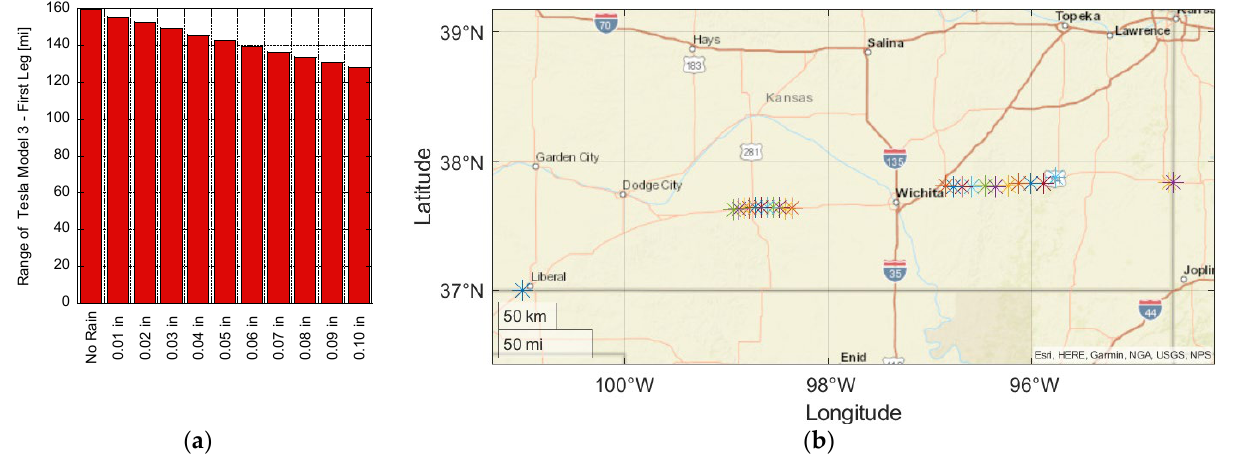
Figure 17. ( a ) Range of Tesla Model 3 in July 2020 heading East on US-54 as a function of rain on road. ( b ) Stopping locations indicated by the symbols * based on rain level with sooner stops needed heading out of Liberal, KS. Vehicle mileage = 1000 miles, HVAC system on.